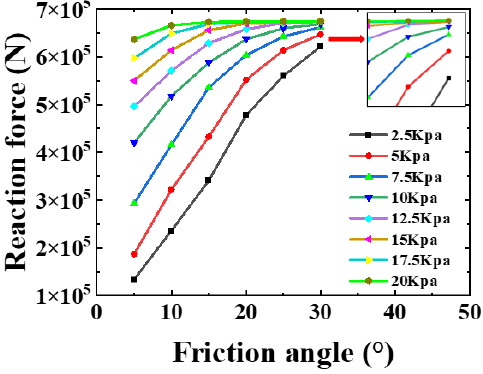
Figure 15. Friction angle – reaction force curve.